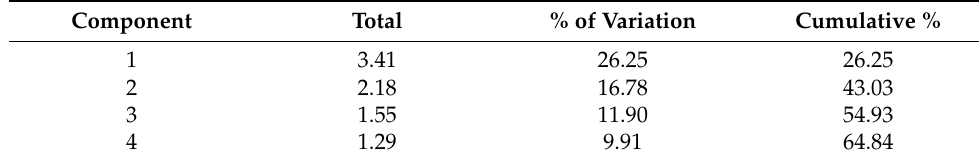
Figure 2. Correlations among selected seawater quality parameters across sites. Correlation plots are shown between NH 3 -N and dissolve oxygen ( A ), BOD 5 and NH 3 -N ( B ), and pH and dissolve oxygen ( C ). Table 2. Total variance explained by PCA.